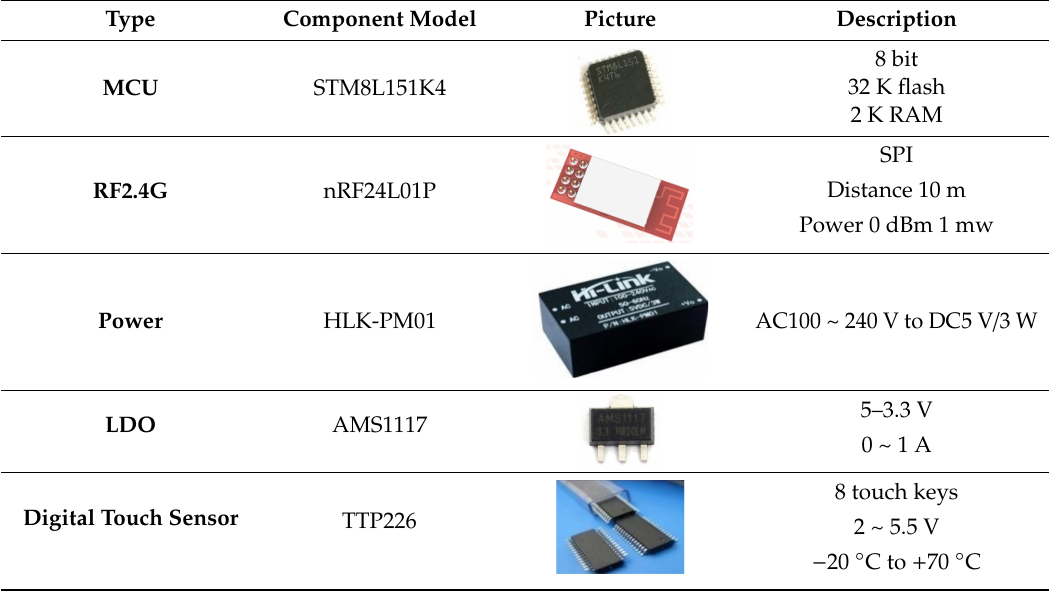
Table 5. Main components of control panel.